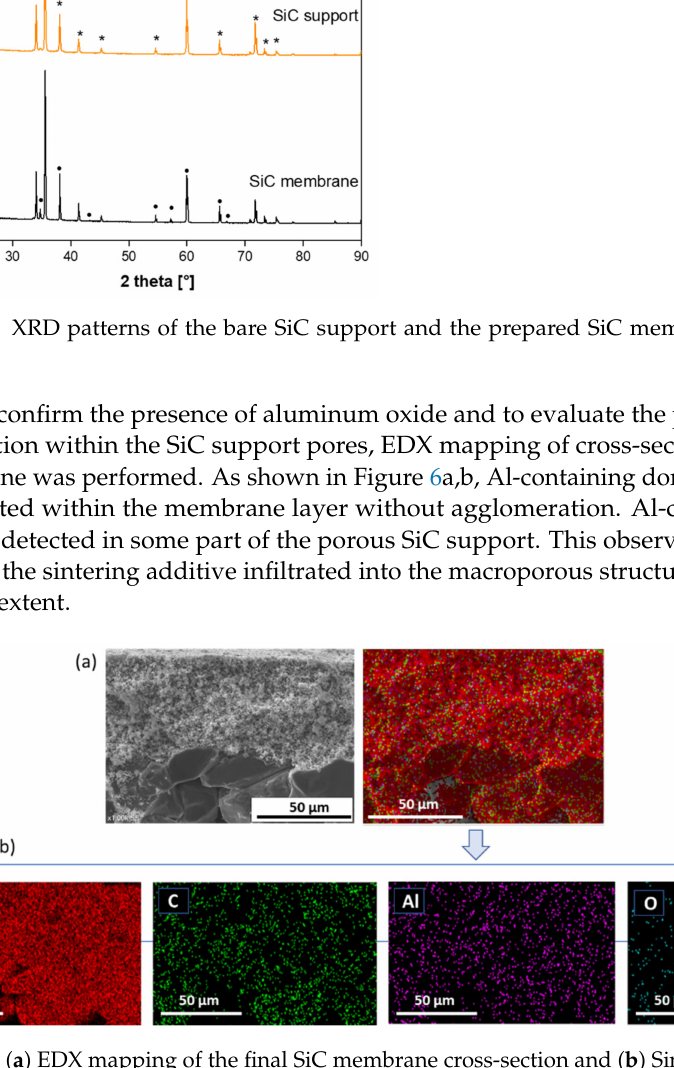
Figure 6. ( a ) EDX mapping of the final SiC membrane cross-section and ( b ) Single element mapping of the final SiC membrane